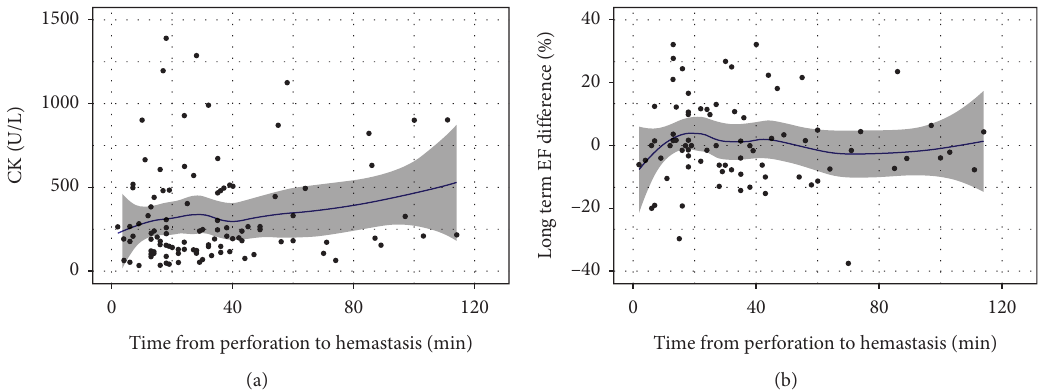
Figure 6: (a) Scatter plot of time from perforation to hemostasis and creatinine kinase (CK); (b) scatter plot of time from perforation to hemostasis and ejection fraction (EF) change from the baseline to